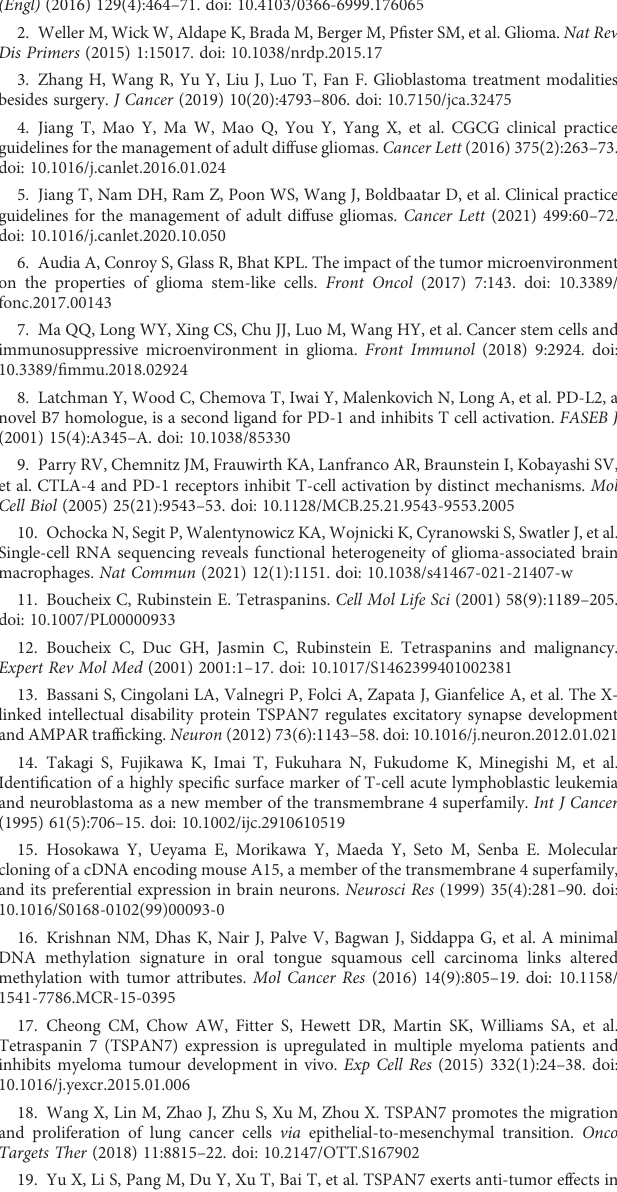
SUPPLEMENTARY FIGURE 6 Relationships between TSPAN7 expression and immune checkpoint markers. (A) Correlationanalysis of TSPAN7 expression with immune checkpoint markers in CGGA dataset. (B) Relative expression level differences of different immune checkpoints between TSPAN7 high expression and low expression subgroup in CGGA dataset. (C, D) Differences in the proportion of patient treatment SUPPLEMENTARY TABLE 1 Clinical characteristics of glioma samples from Xiangya hospital. SUPPLEMENTARY TABLE 2 GO enrichment of downregulated genes about immune